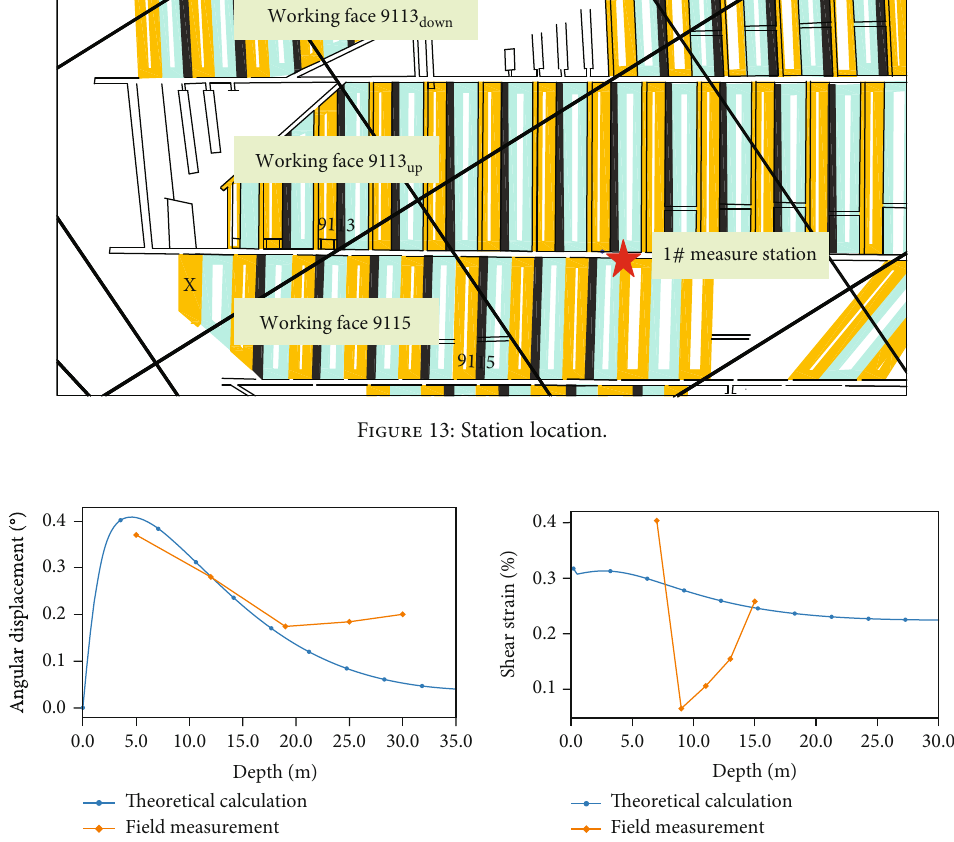
Figure 14: Deformation law of fl oor rock mass: (a) measuring station 1#; (b) measuring station 2#.